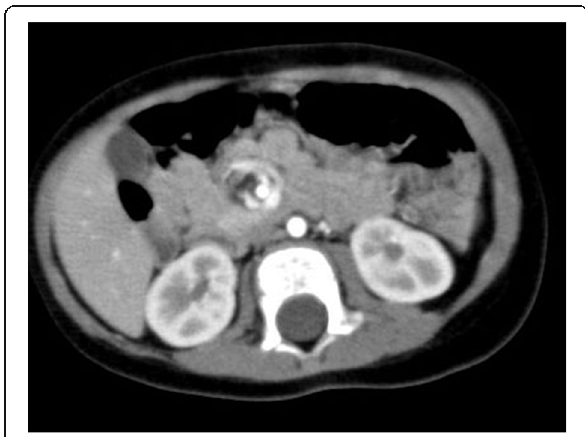
Fig. 1 Contrast-enhanced CT: a whirlpool sign at the right upper abdomen. Neither intrahepatic portal venous gas nor signs of pneumatosis intestinalis were observed